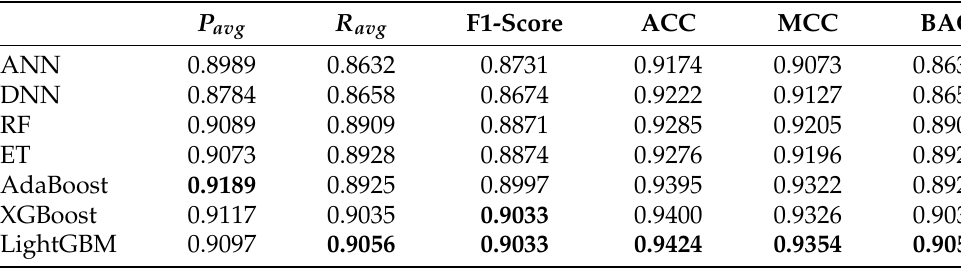
Table A4. Measured metrics for permission set